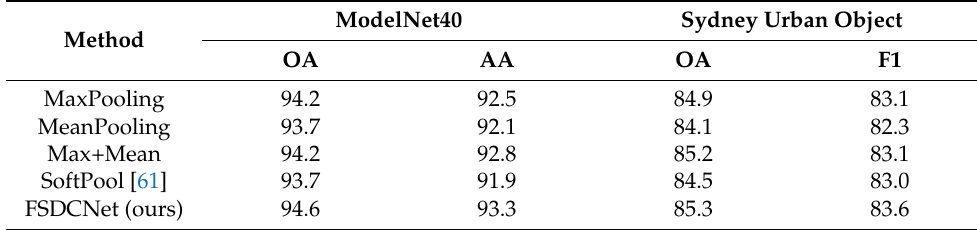
Table 7. Comparison of classification performance with different global